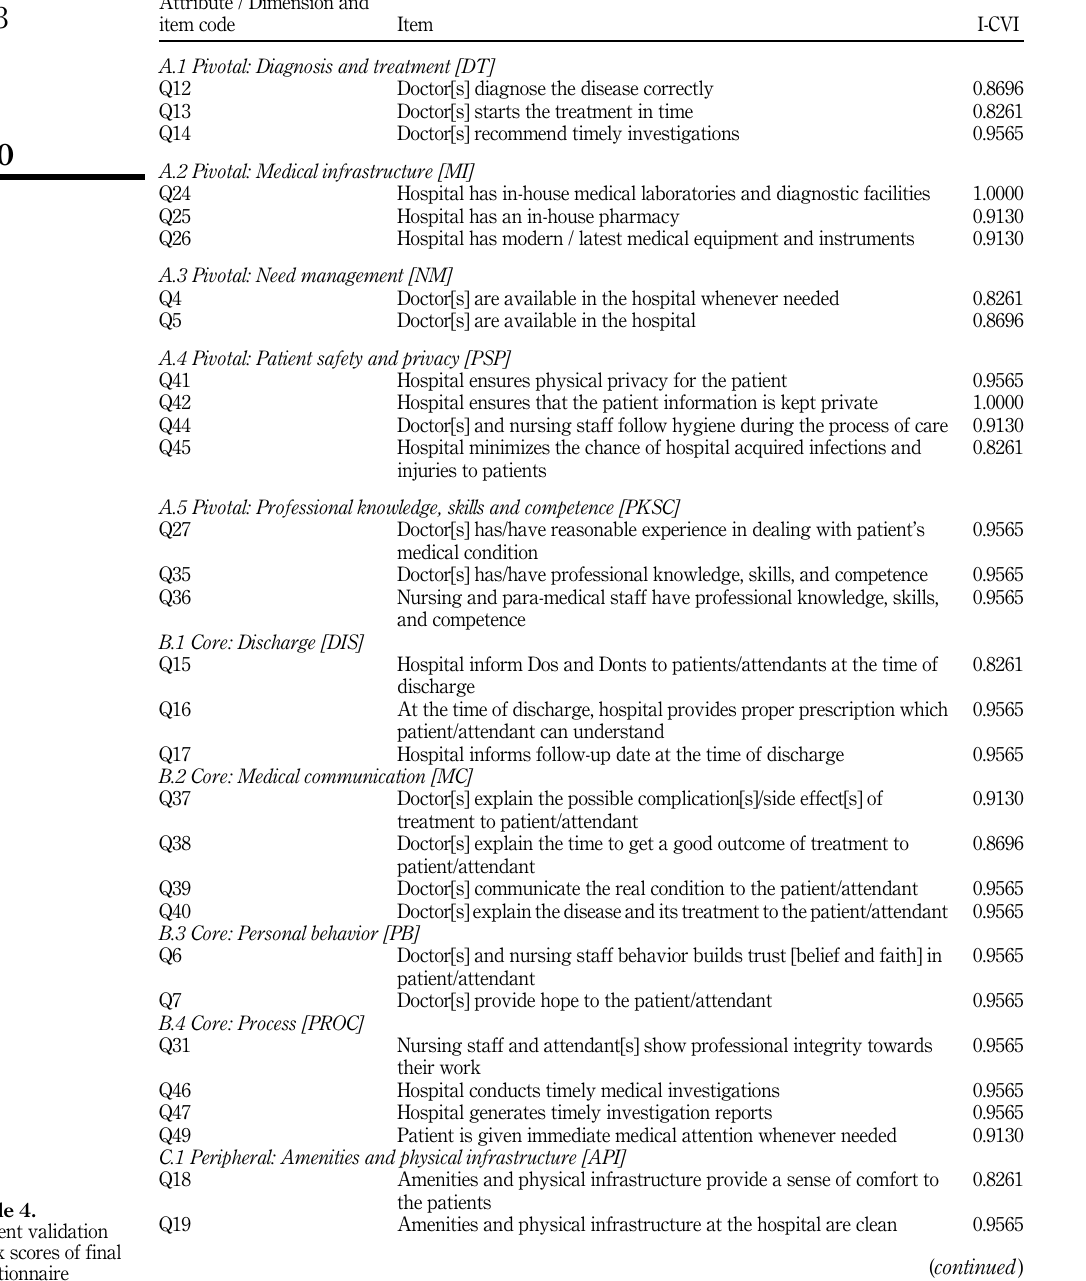
index scores of final